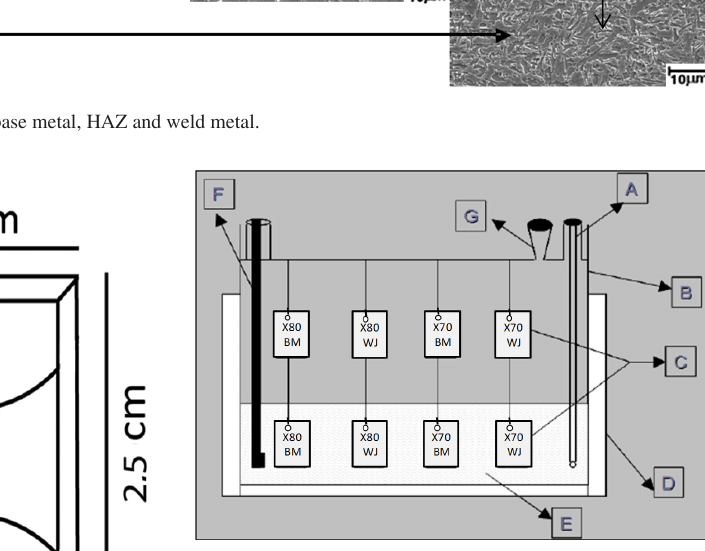
Figure 3. Schematic representation of the immersion test, where (A) thermometer, (B) cell, (C) samples (immersed and vapour), (D) thermostatically controlled bath, (E) 1% wt. NaCl solution, (F) gas inlet, (G) gas outlet, BM (Base Metal), WJ (Welded